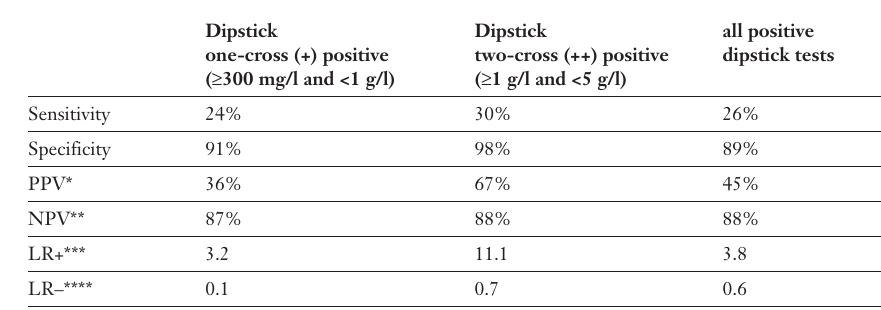
Characteristics of the patients with newly diagnosed, untreated arterial hypertension (n = 186); SD = Stan- dard deviation.